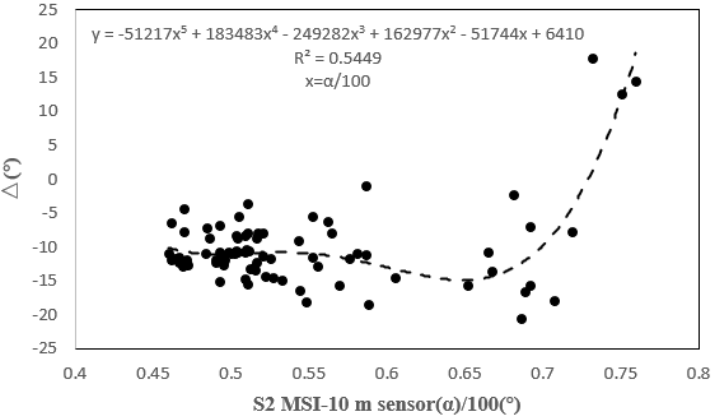
Figure 3. Deviation in degrees from the hyperspectral hue angle for Sentinel-2 MSI.